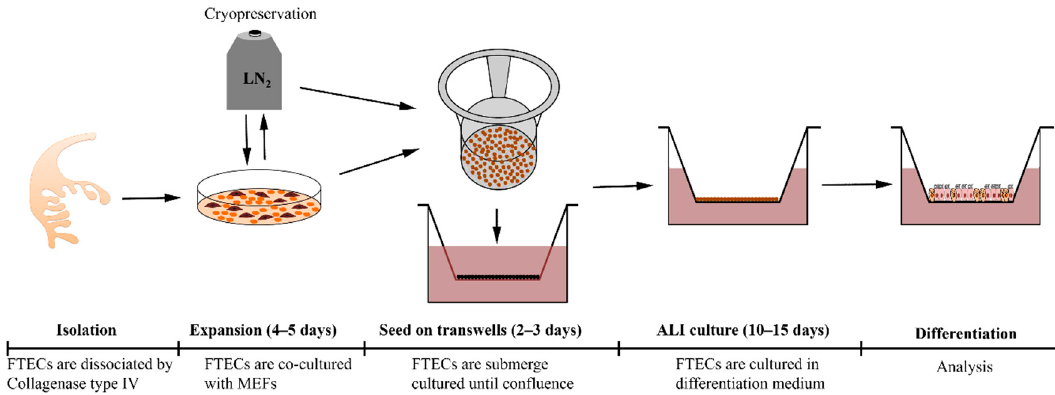
Figure 7. Overview of FTECs primary culture and strategy for inducing the multi-ciliated cells (MCCs) by ALI culture. FTECs were dissociated by collagenase IV and co-cultured with MEF cells to expand the colonies. After expansion, FTECs were seeded onto collagen I-coated porous supports and cultured with the basal medium. After reaching confluency, defined supplements were added to induce ciliogenesis. ALI culture conditions involved removing the medium from the top chamber so the liquid interface barely covered the apical surface of the epithelial sheet.